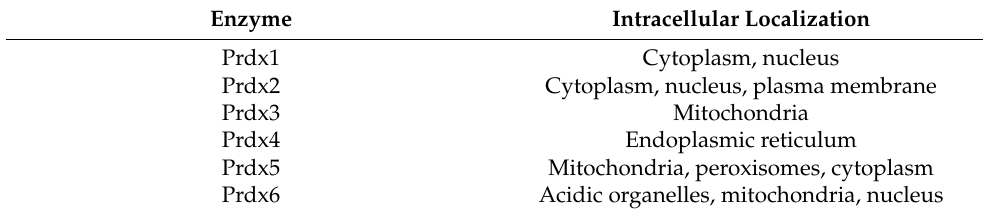
Table 1. Intracellular localization of